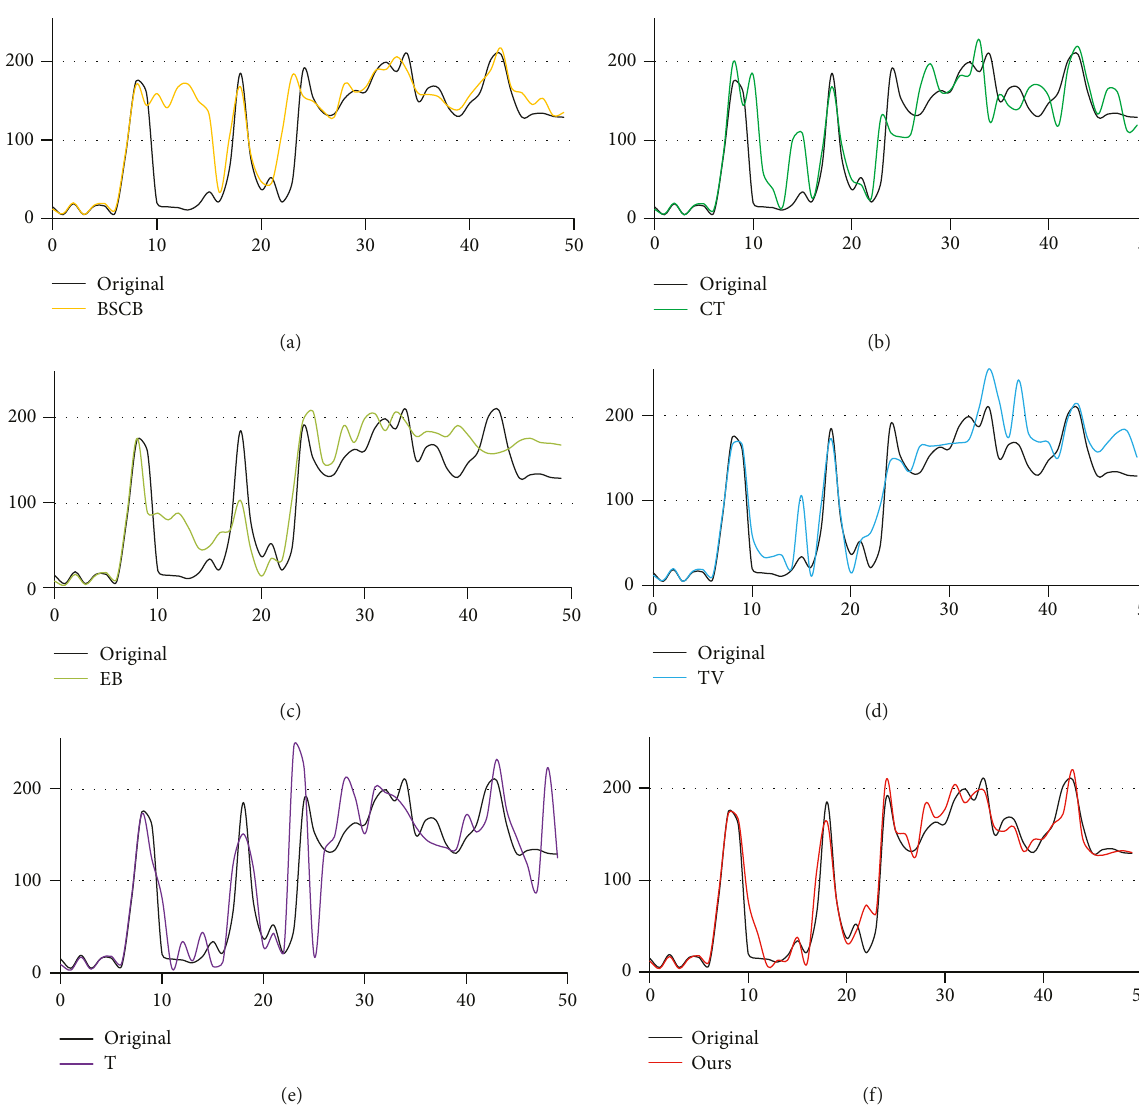
Figure 13: The intensity distribution of one column of repaired image patches. (a) By BSCB; (b) by CT; (c) by EB; (d) by TV; (e) by Thiele’s interpolation; (f) by our